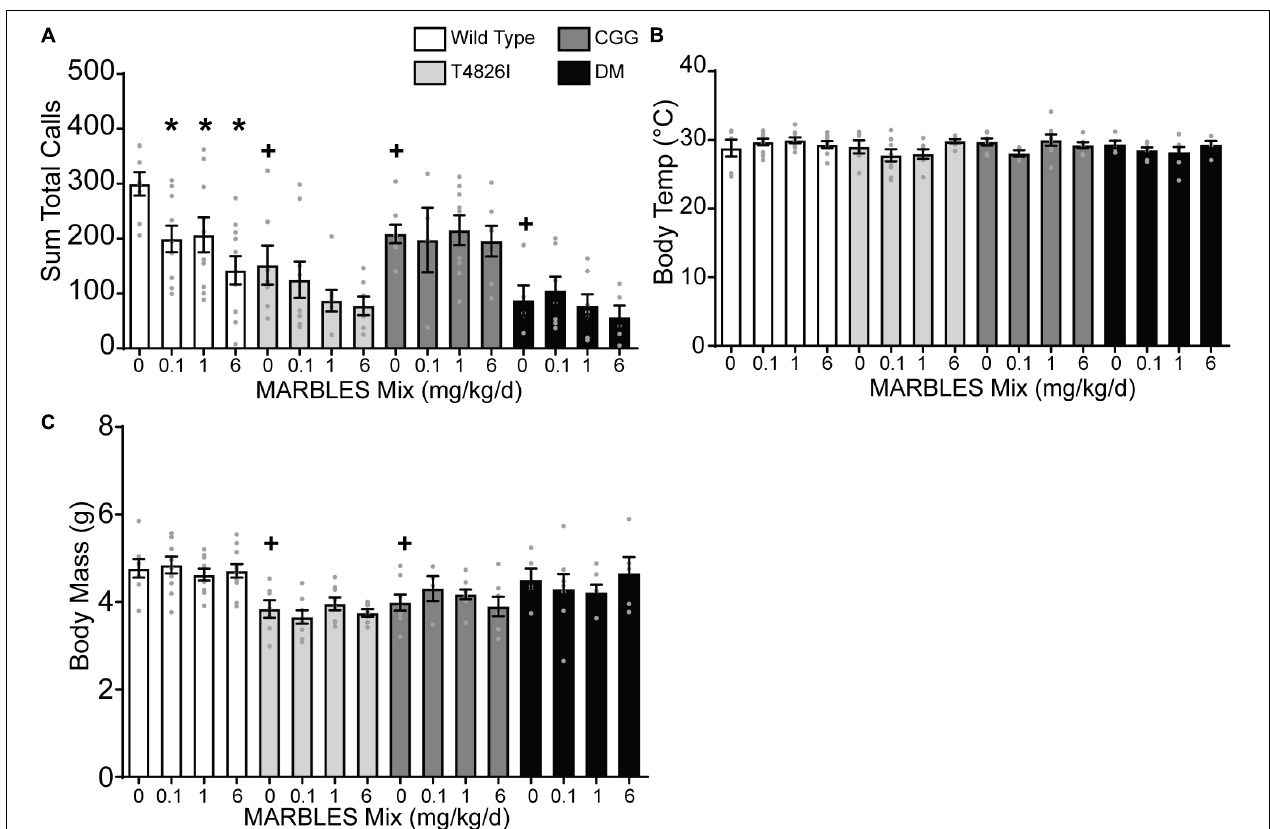
FIGURE 1 | Developmental PCB exposure or expression of mutations in calcium signaling decreased the number of ultrasonic vocalizations (USVs) emitted from pups at P7. (A) The sum total calls made during the 3-min testing period averaged per litter. (B) Body temperature during the testing period averaged per litter. (C) Body mass during the testing period averaged per litter. Only litters of 6–8 pups were used for analysis with n = 4–11 litters per group. Data are presented as mean ± SEM. *Indicates significantly different from vehicle control within a genotype, + indicates significantly different from WT vehicle control at p < 0.05 as determined using a one-way ANOVA or Kruskal Wallis test with post hoc Holm-Sidak’s multiple comparisons test or Dunn’s test,